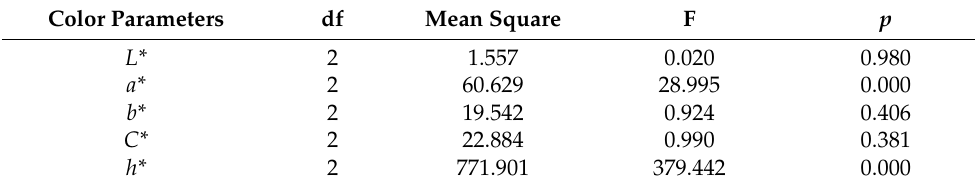
Table 4. ANOVA results for the color